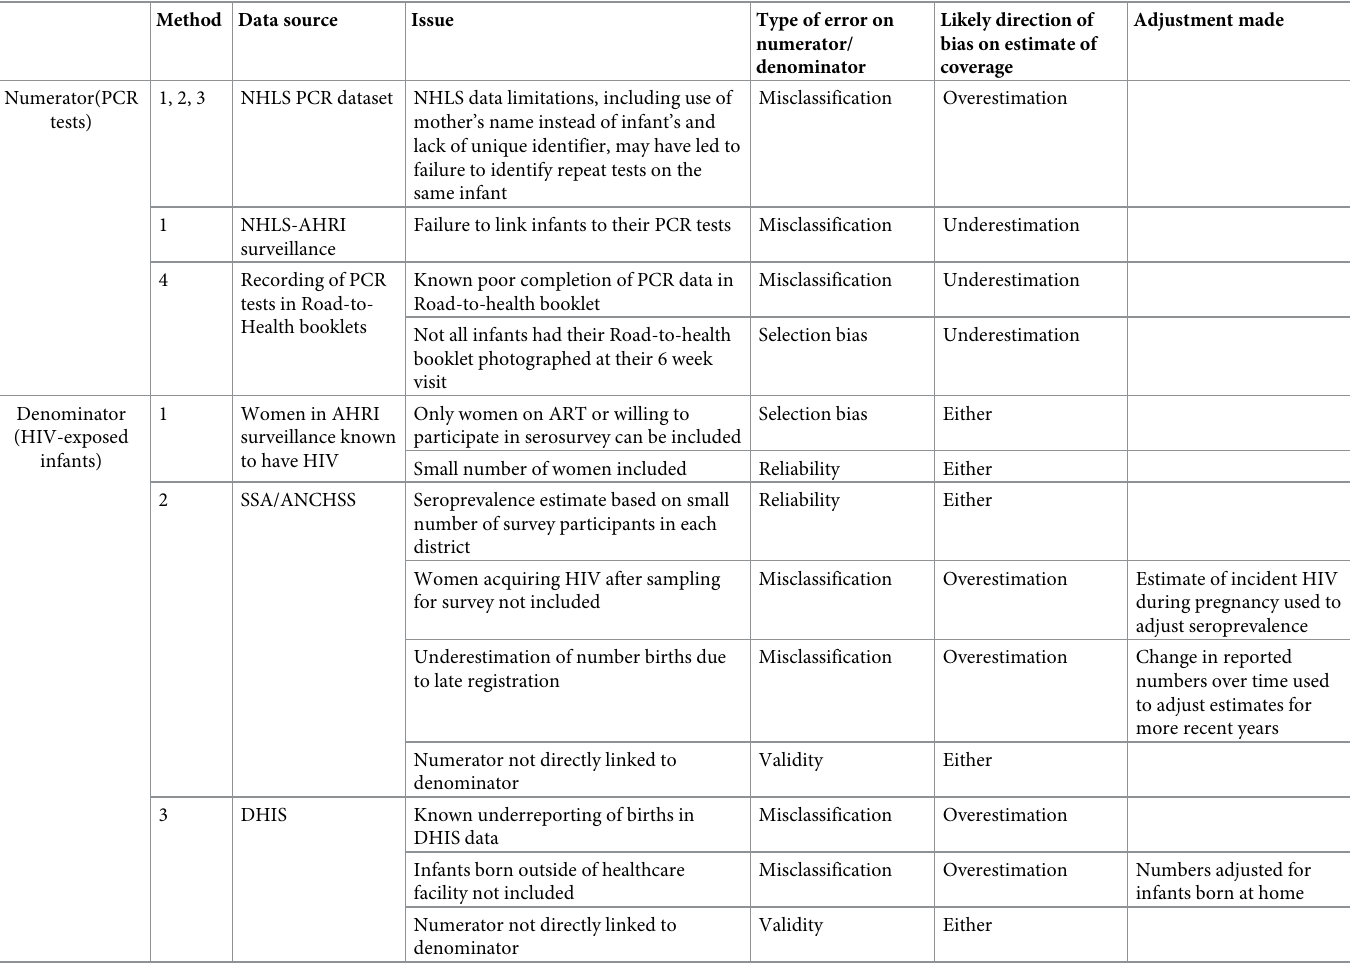
Table 3. Limitations of the methods and the likely direction of bias on the estimate of coverage. Method Data